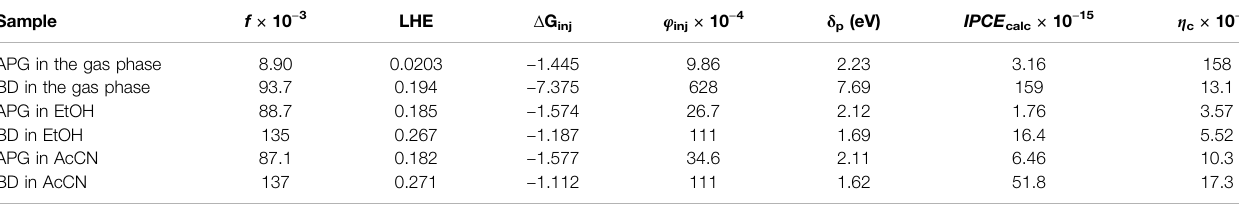
TABLE 4 | Computed photophysicochemical and photovoltaic parameters of the APG and BD in gas and solution phases.